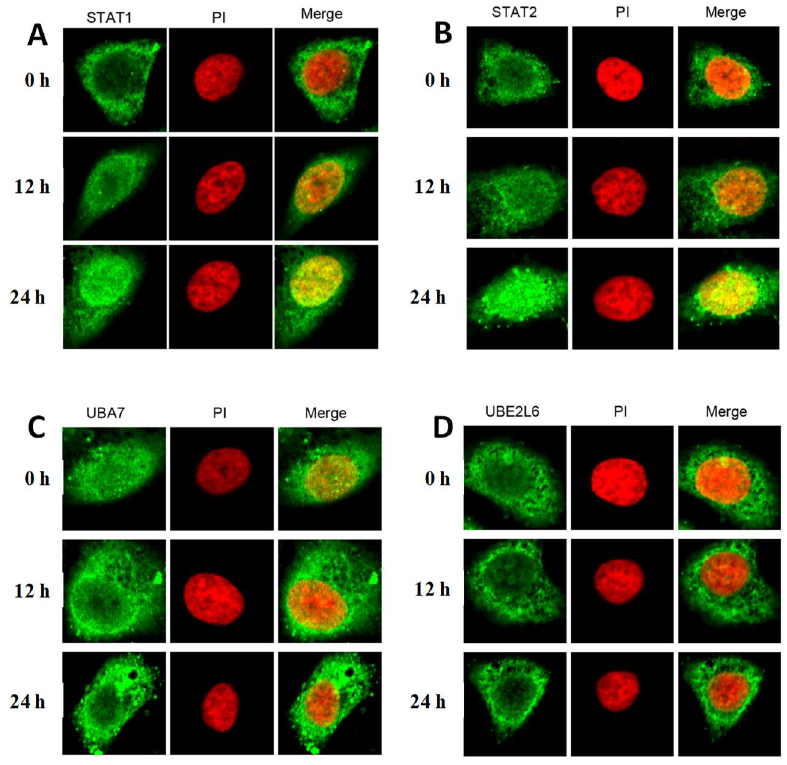
Figure 2. Translocation detection of four factors in HepG2 cells treated by furosine (100 mg/L) by confocal. ( A ) STAT1 in cell; ( B ) STAT2 in cell; ( C ) UBA7 in cell; ( D ) UBE2L6 in cell. Green light stands for proteins of interest in the cell, and red light stands for the nucleus. The pictures were captured at 100× magnification.